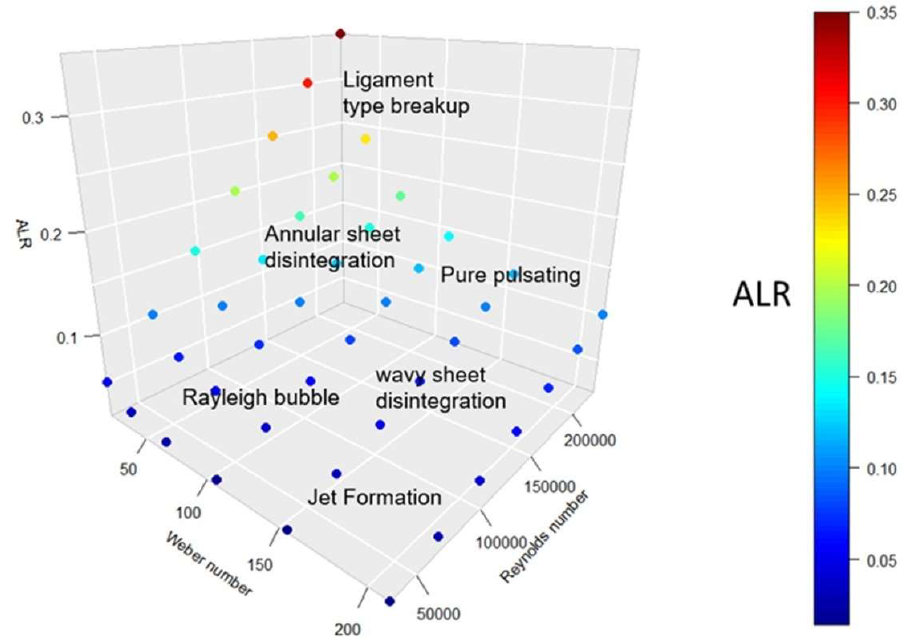
Figure 8. Regime chart for the converging atomizer for various flow rates for 280 µm sheet thick- ness.